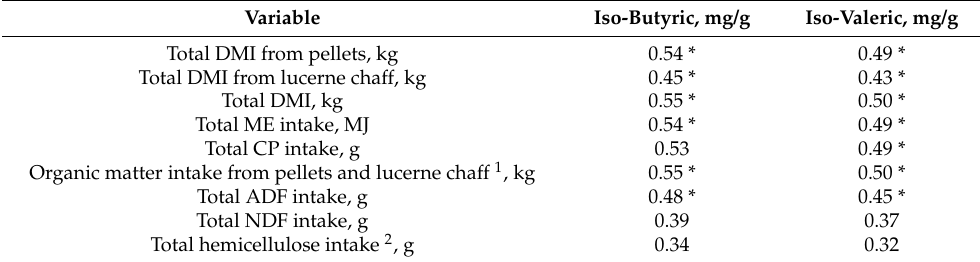
Table 7. Pearson correlation coefficients of dietary factors and iso-butyric, and iso-valeric content of rumen fluid of artificially reared lambs exposed to three rearing treatments (DMI, dry matter intake; ME, metabolisable energy; CP, crude protein; ADF, acid detergent fibre; NDF, neutral detergent fibre). Variable Iso-Butyric, mg/g Iso-Valeric, mg/g Total DMI from pellets,